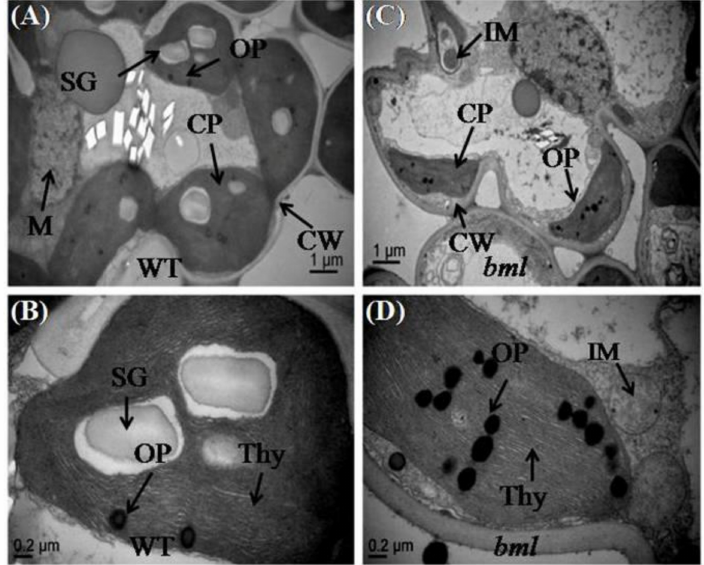
Figure 4. Ultrastructure of chloroplasts in the middle part of the second leaf blade from the top of bml mutant rice plants. ( A , C ) Magnified view of chloroplasts in mesophyll cells of bml and WT plants